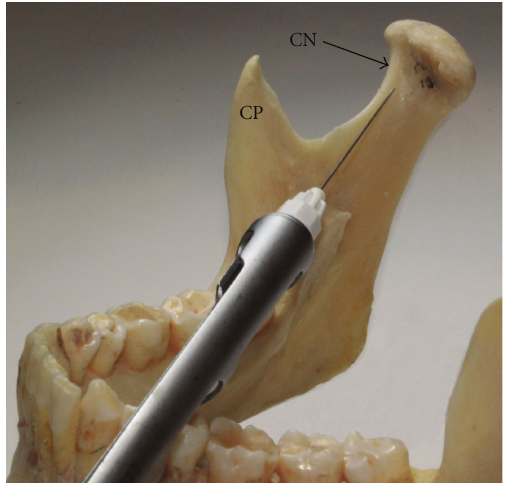
Figure 5: Photograph of the mandible showing the ideal needle tip position when administering the Gow-Gates mandibular block technique. The intended target area for the needle is the lateral condylar neck region, below the insertion of the lateral pterygoid muscle and the attachment of ligaments associated with the temporomandibular capsule (CN: condylar neck, CP: coronoid